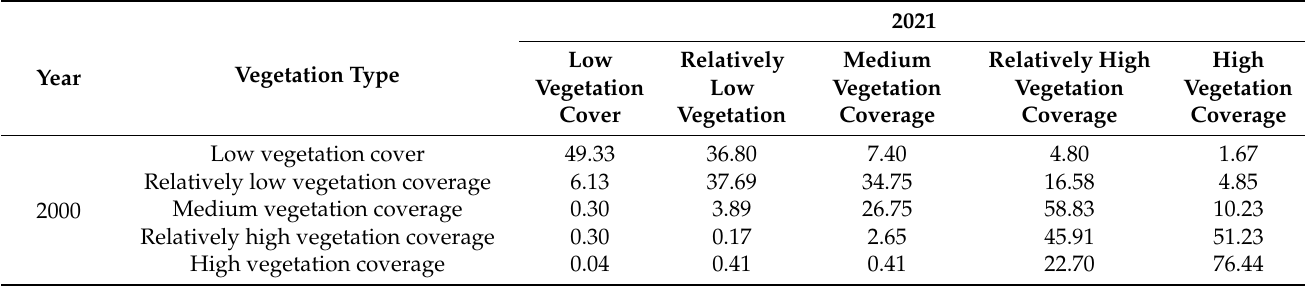
Table 4. NDVI transfer probability matrix of the LMRB in 2000 and 2021 (%).